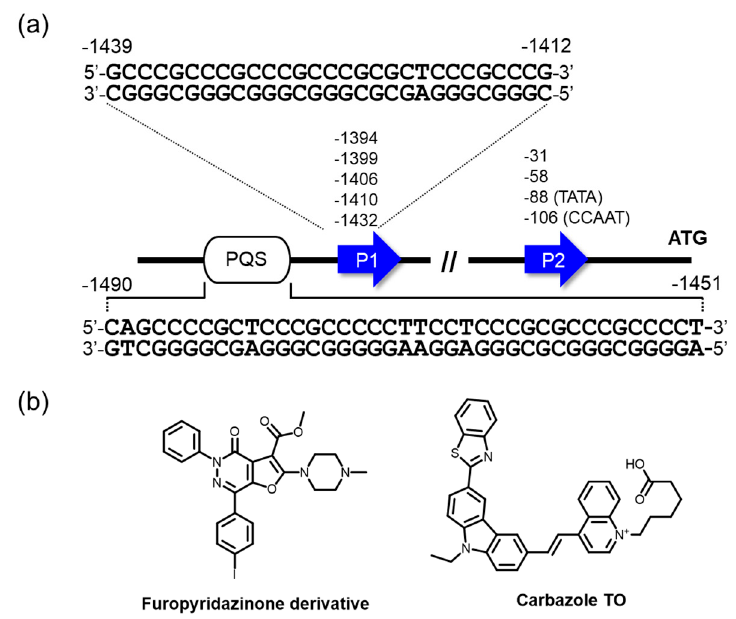
Figure 5. ( a ) The BCL2 promoter has two G4-forming elements that were shown to attenuate the BCL2 promoter activity. ( b ) Molecules preferentially interacting with the G4 (distal one) over other G4 structures. An antitumor activity of furopyridazinone derivative is summarized in Table 1.